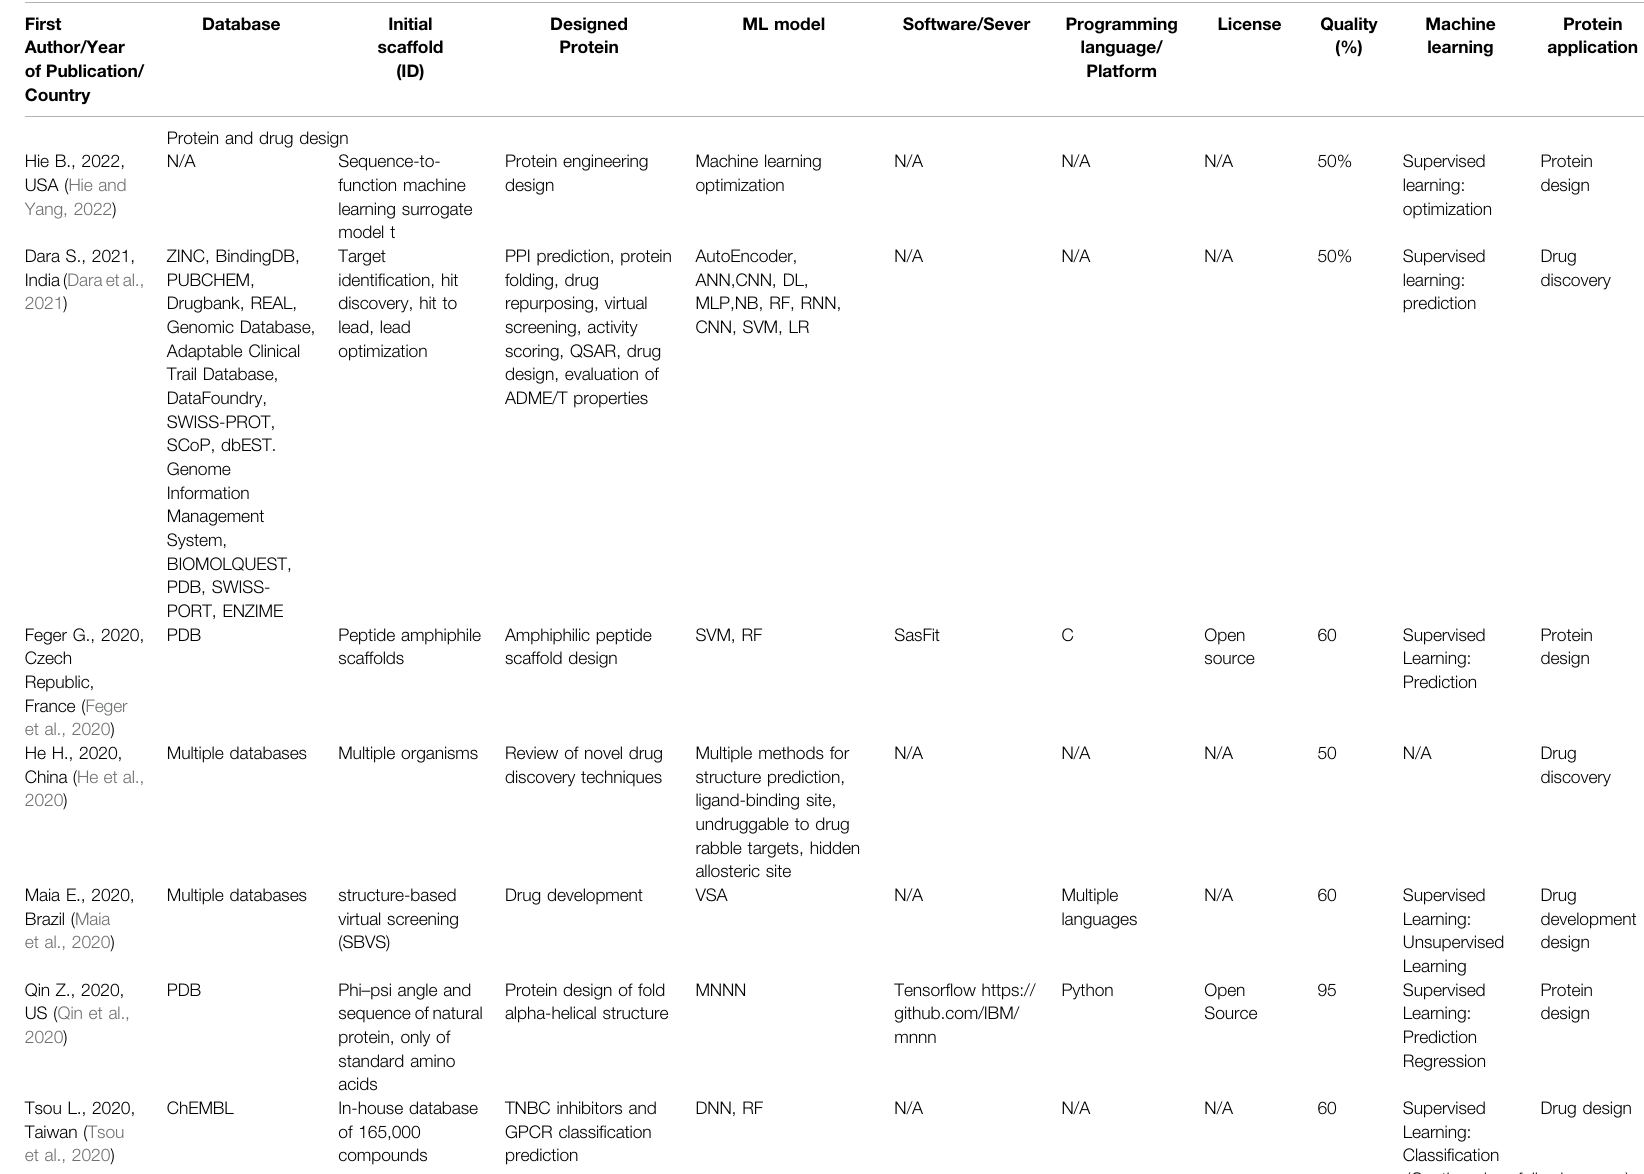
TABLE 2 | An overview of the protein and drug design articles with the quality